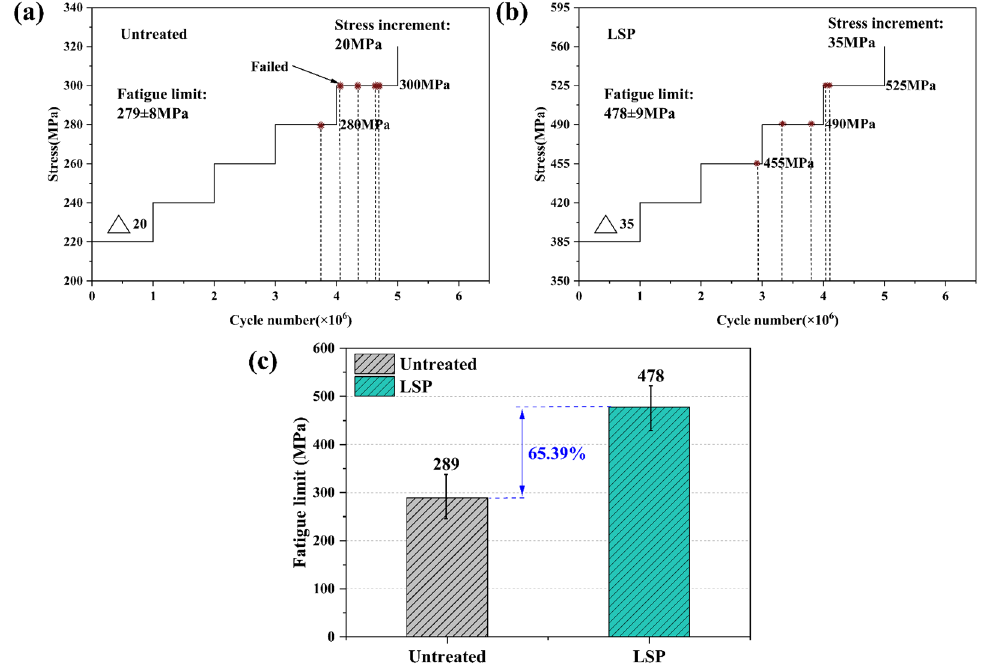
Figure 11. High-cycle vibration fatigue limit at 10 6 cycle numbers of as-welded specimens treated using LSP. ( a ) Untreated. ( b ) LSP. ( c ) High-cycle fatigue test results of weld specimens.